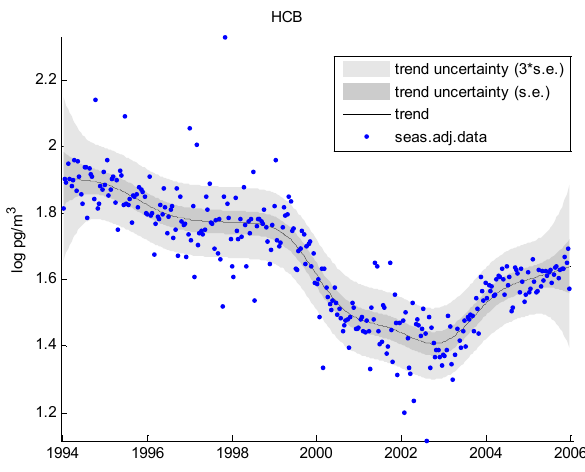
Fig. 6. Seasonally adjusted data and underlying trend for